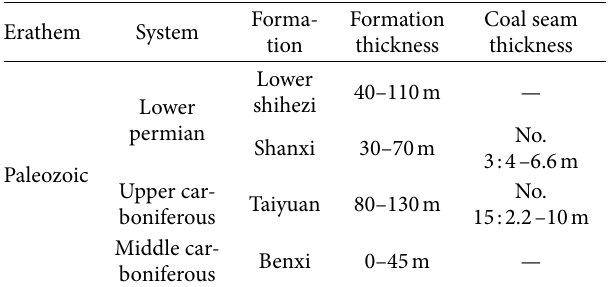
Table 1: Some geological information of the Nos. 3 and 15 coal